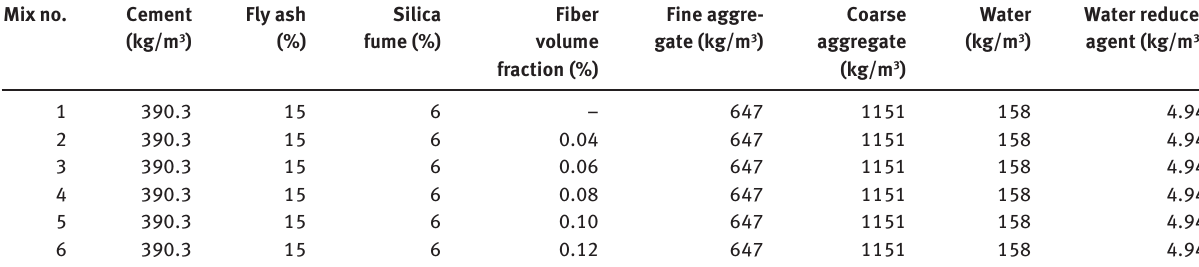
Table 3 Mix proportions of the